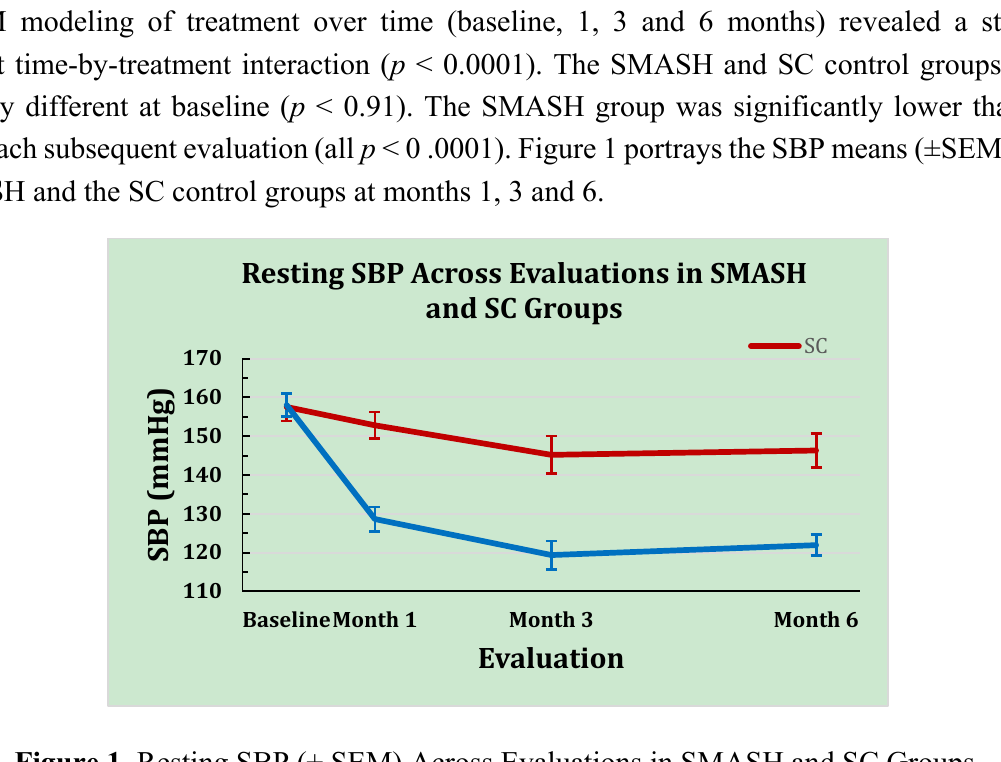
Figure 1. Resting SBP (± SEM) Across Evaluations in SMASH and SC Groups.